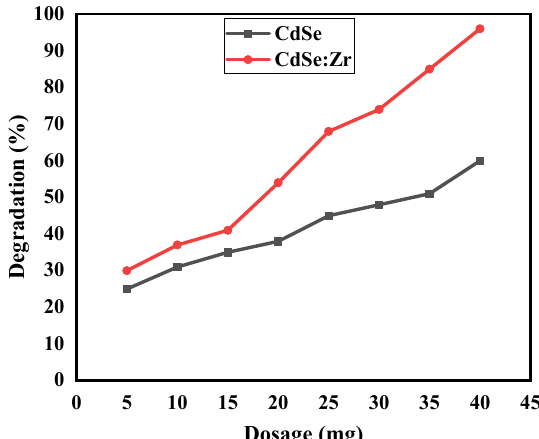
Fig. 8. Effect of dose of the catalyst on the photodegradation of IC dye